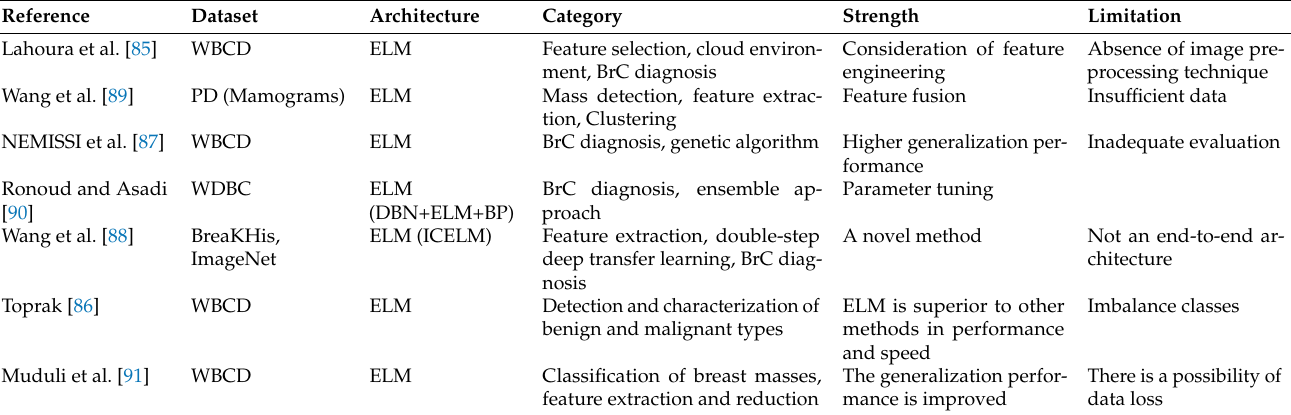
Figure 7. A basic extreme learning machine architecture. Table 8. State-of-the-art studies based on ELM